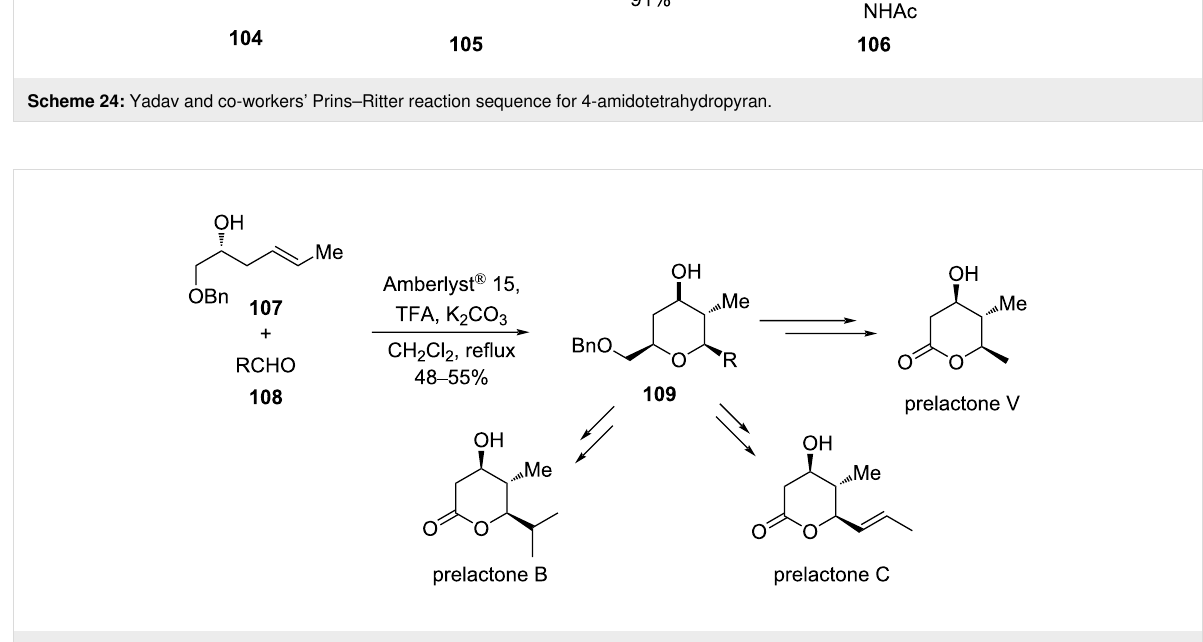
Scheme 25: Yadav and co-workers’ strategy to prelactones B, C, and V.